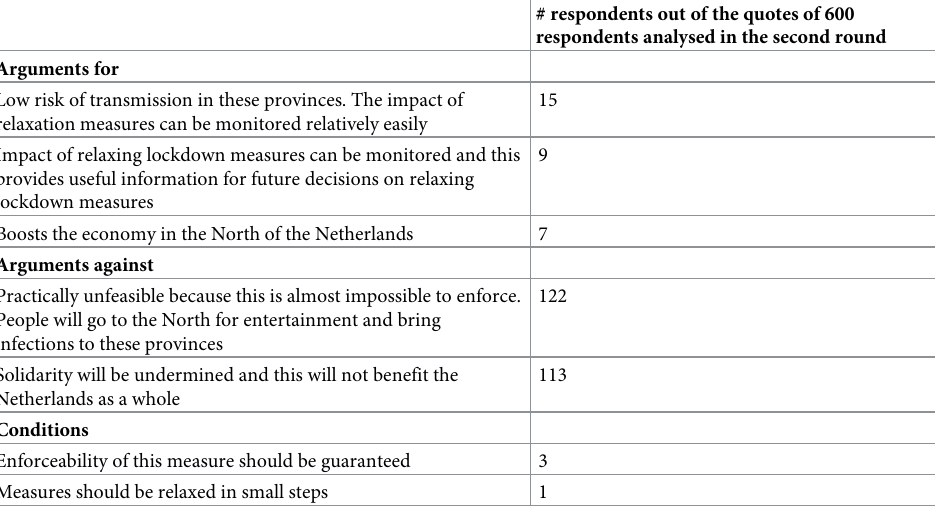
# respondents out of the quotes of 600 respondents analysed in the second round